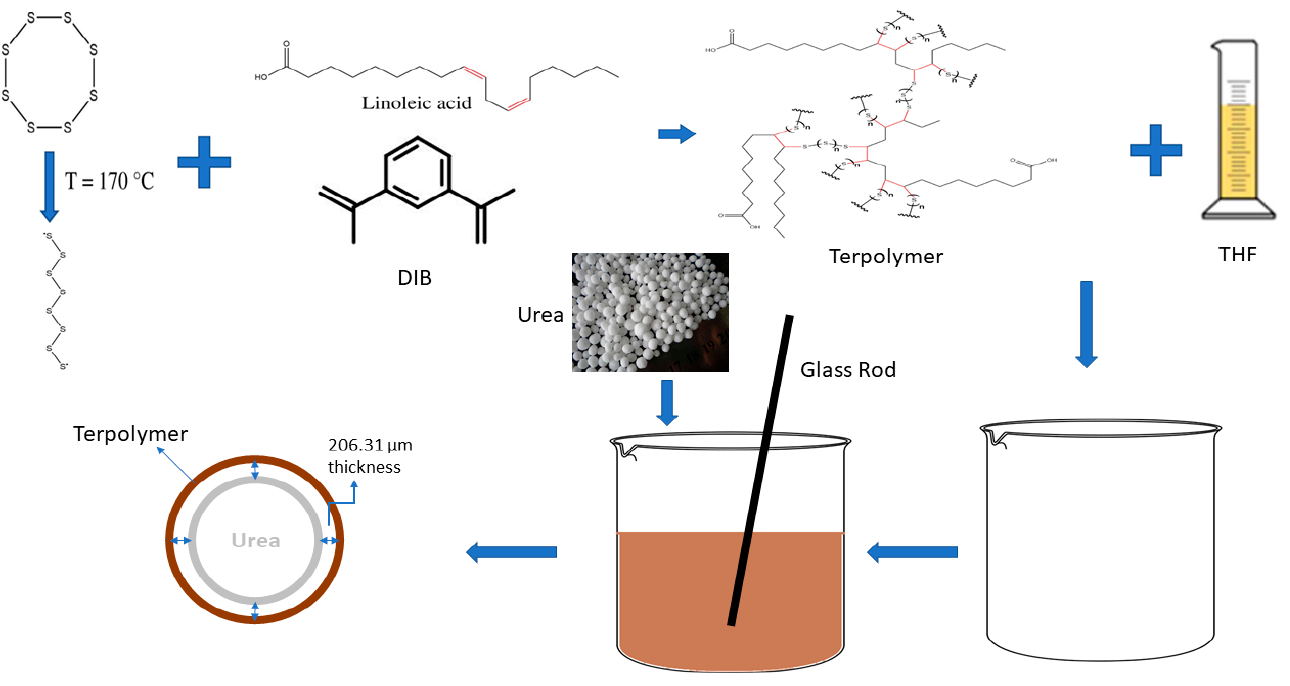
Figure 1. Schematic of the research work.